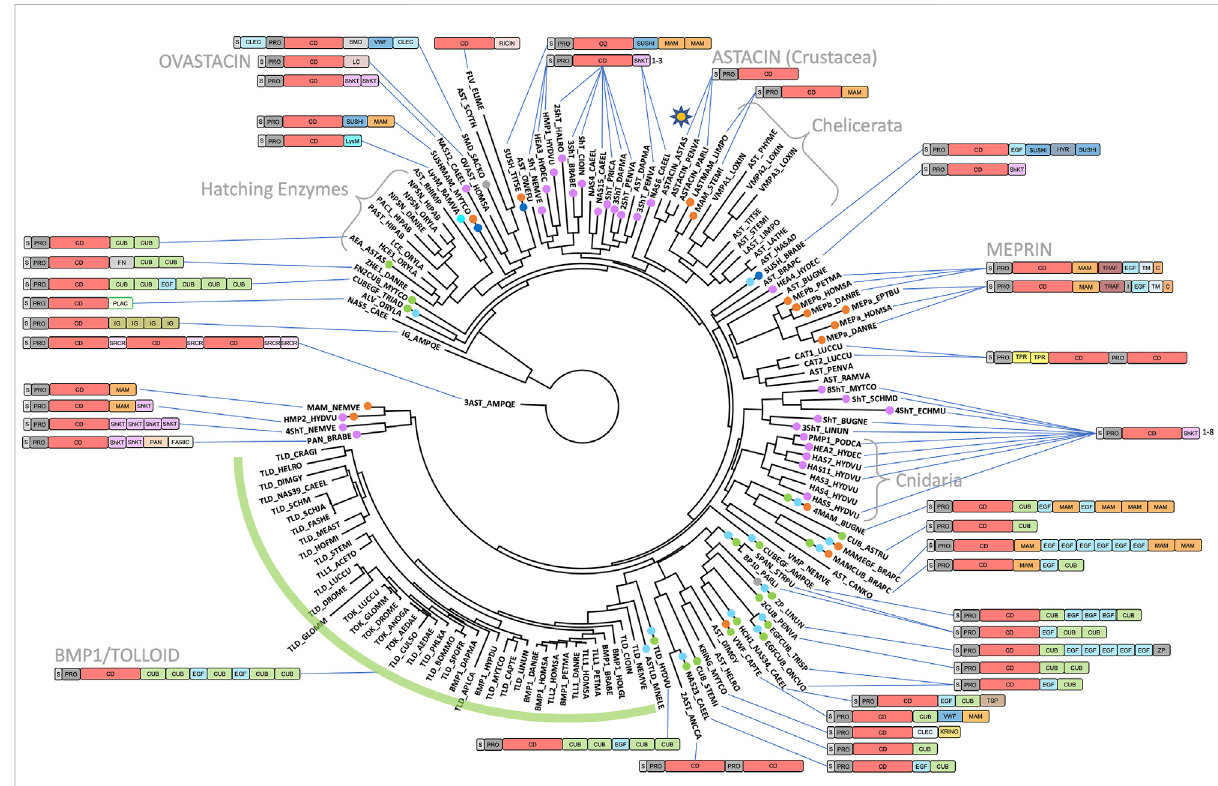
FIGURE 5 Phylogenetictreebasedonthecatalyticdomainsofaselectionof147astacins.Thelistofspeciesand UniProt and GenBank accessionnumbers are listed in Supplementary Table S1. The asterisk in the top right quadrant indicates the position of the prototypical name-giving enzyme astacin fromthecray fi sh Astacusastacus .Cray fi sh astacinistranslated withasignalpeptide for extracellulartargeting,aprodomainconferringlatency anda catalytic protease domain (see also Figure 1). The domain compositions of astacins consisting merely of these three domains are omitted for clarity. Astacin-like proteases with more complex domain structures are shown schematically. A detailed list of domains with Prosite database accession numbers is contained in Figure 1 and in Supplementary Table